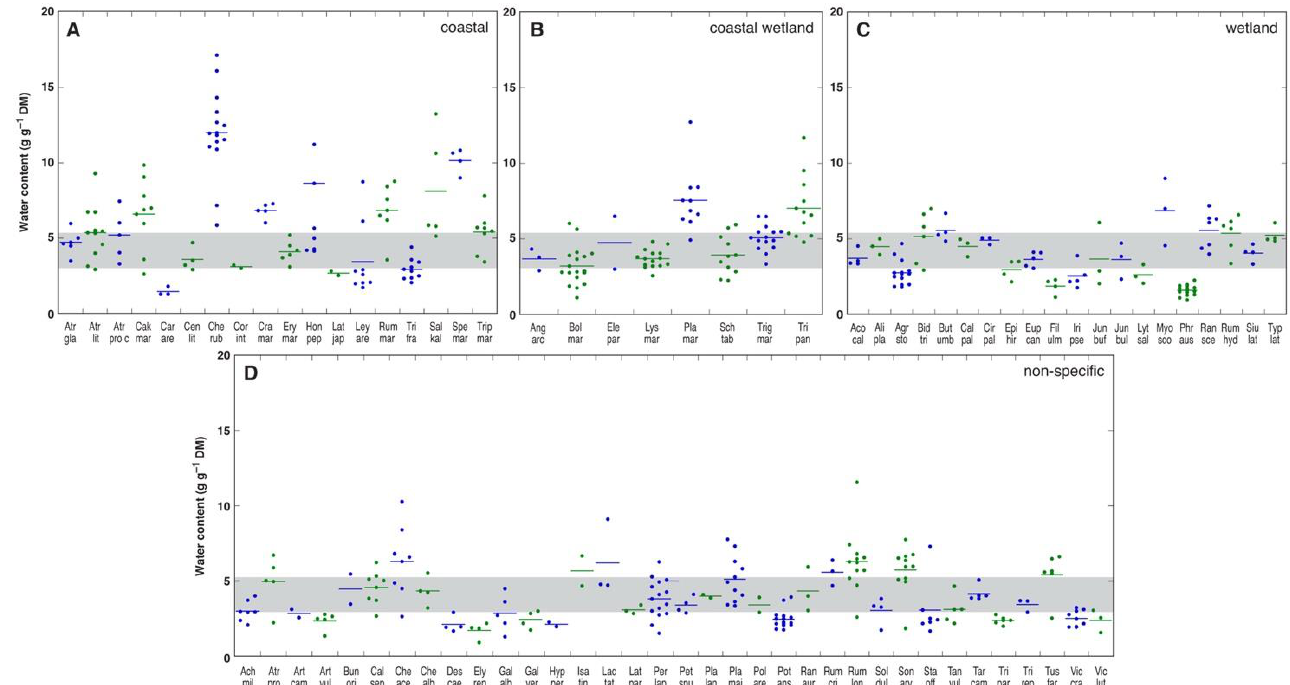
Figure 2. Leaf water content in different species from salt-affected coastal habitats. ( A ), Coastal- specific species; ( B ), coastal-specific wetland species; ( C ), wetland-specific species; ( D ), non-specific species. Each point represents a mean value of water content for a particular distant site. Grey area indicates the middle 50% values among means from all analyzed species. Modified from the data of Ievinsh et al., 2021 [143]. Different color of symbols is used simply for the sake of comprehensibility. “Succulent halophytes” is a descriptive term used for plants that seem to accumulate water under increased soil salinity, presumedly serving both as a water reserve as well term “succulent” is mostly used to indicate the “fleshy” appearance of leaves and